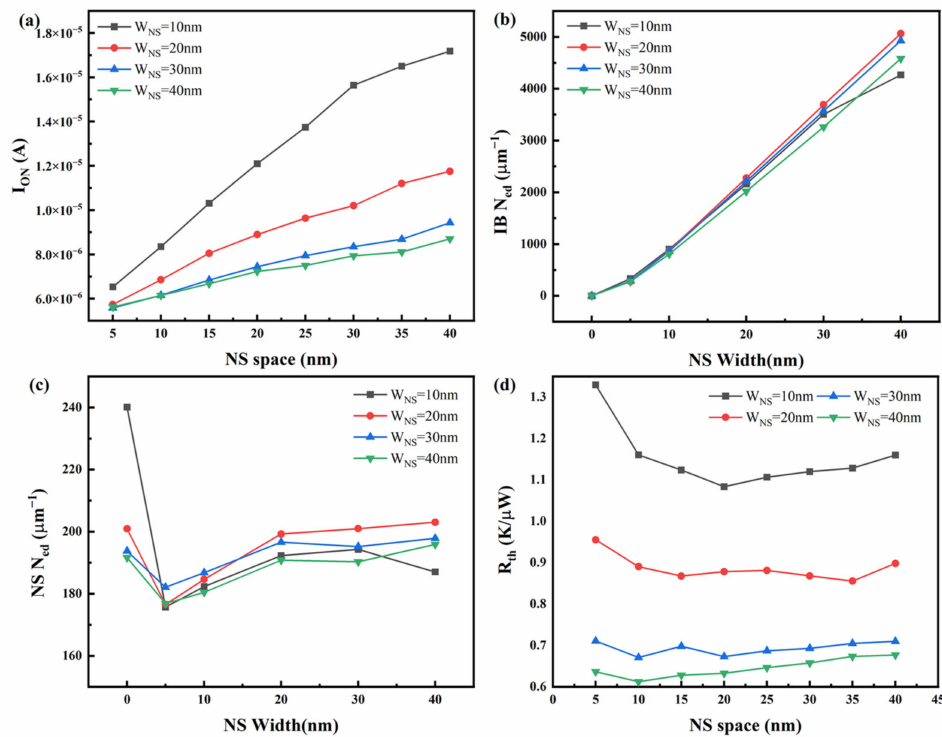
Figure 15. Impact of S NS : ( a ) normalized I ON ; ( b ) total IB line electron density; ( c ) normalized total NS line electron density; ( d ) R th of the TreeFET with different W NS at W IB = 4 nm and V GS = V DS = 0.7 V.